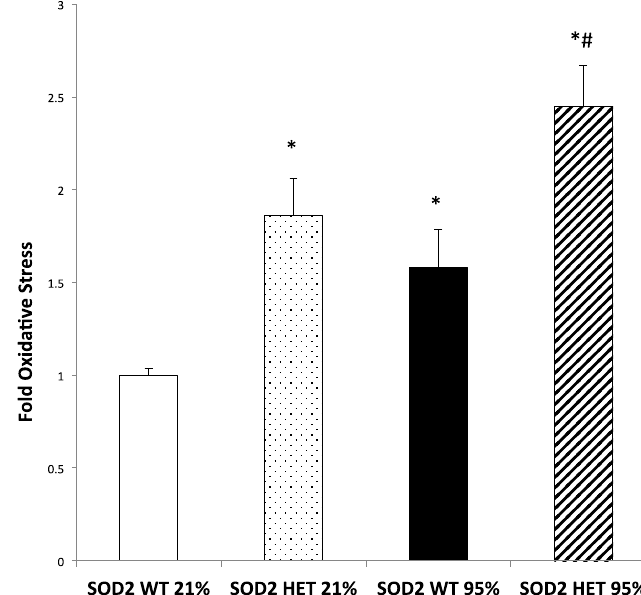
Figure 3. Hyperoxia increased ROS in both SOD2+/+ and SOD2−/+ PASMCs. PASMC were isolated from both SOD2−/+ (HET) and SOD2+/+ (WT) mice. PASMC were exposed to hyperoxia (95% O 2 ) for 24 h. We utilized a targeted ratiometric redox-sensitive GFP probe (mitoRoGFP) to measure oxidative stress. After obtaining ratiometric measurements of RoGFP using dual laser flow cytometry, the sensor was calibrated by maximally reducing it with dithiothreitol (DTT, 1 mM) and maximally oxidizing it with t-butyl hydroperoxide (TBH, 1 mM). Data are shown as mean fold oxidative stress relative to SOD2+/+ (WT) PASMC in 21% O 2 ± SEM ( n = 7 (WT 21% O 2 ), 9 (HET 21% O 2 ), 8 (WT 95% O 2 ), and 10 (HET 95% O 2 ); * p < 0.05 vs. SOD2 WT in 21% O 2 , # p < 0.05